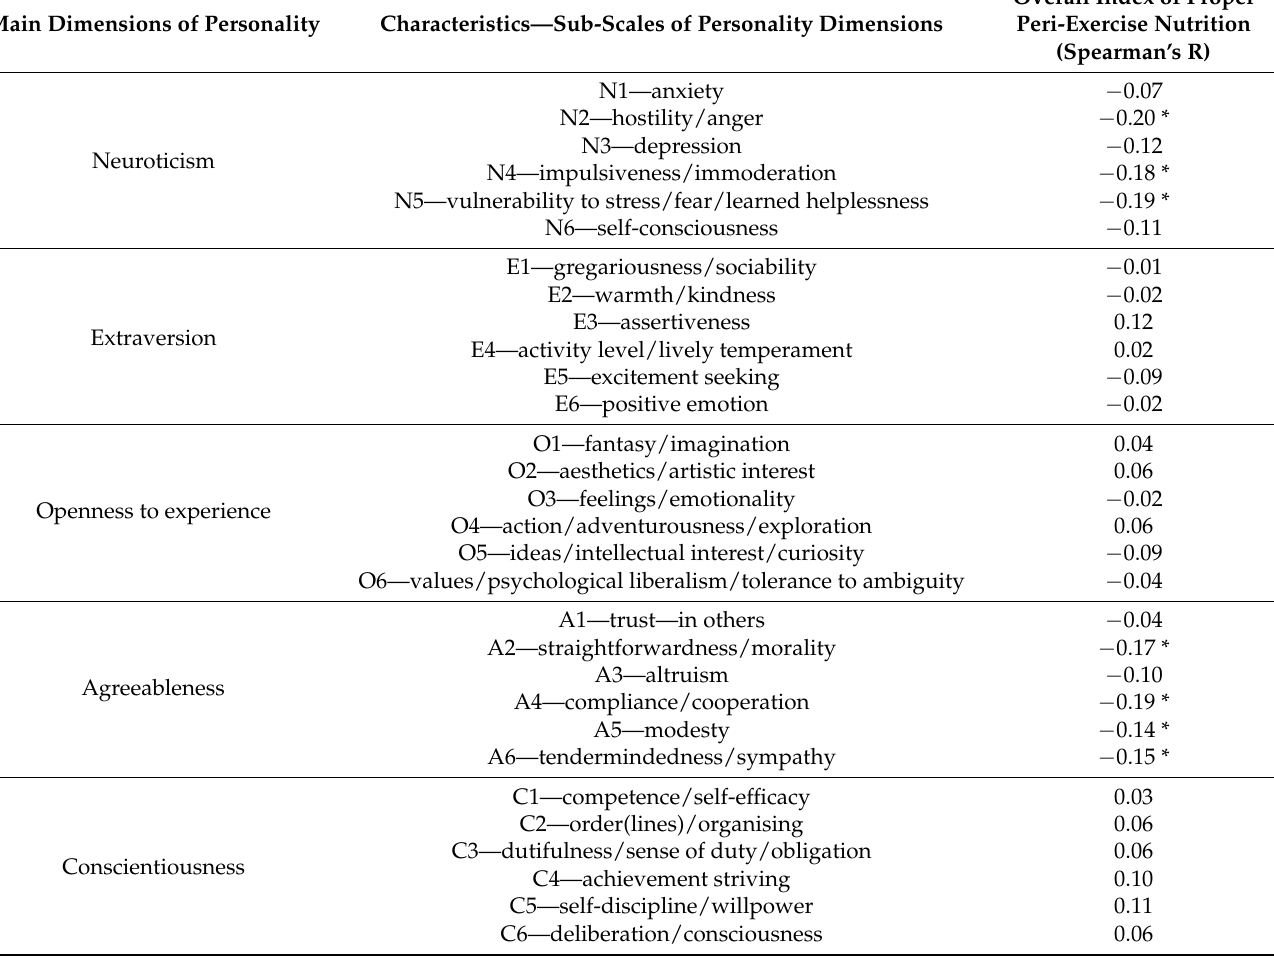
Table 4. Correlations between the characteristics (sub-scales) of the personality dimensions from the Big Five model and the overall index of proper peri-exercise nutrition among athletes training team sports (N = 213) (Spearman’s rank correlation coefficient values).